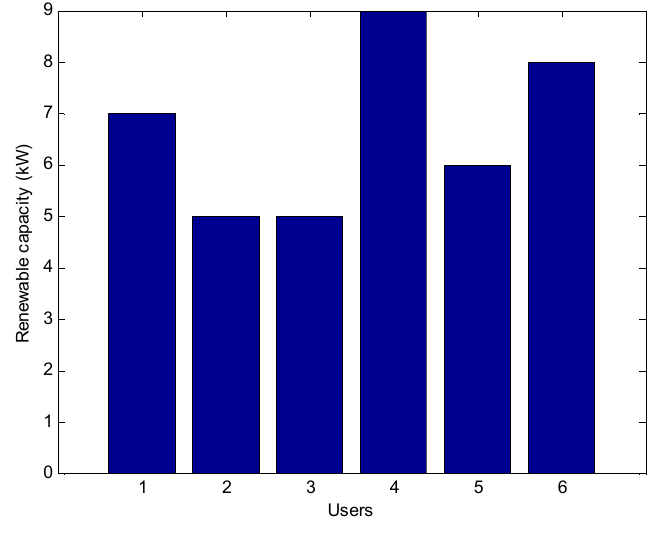
Figure 5. Renewable capacity.